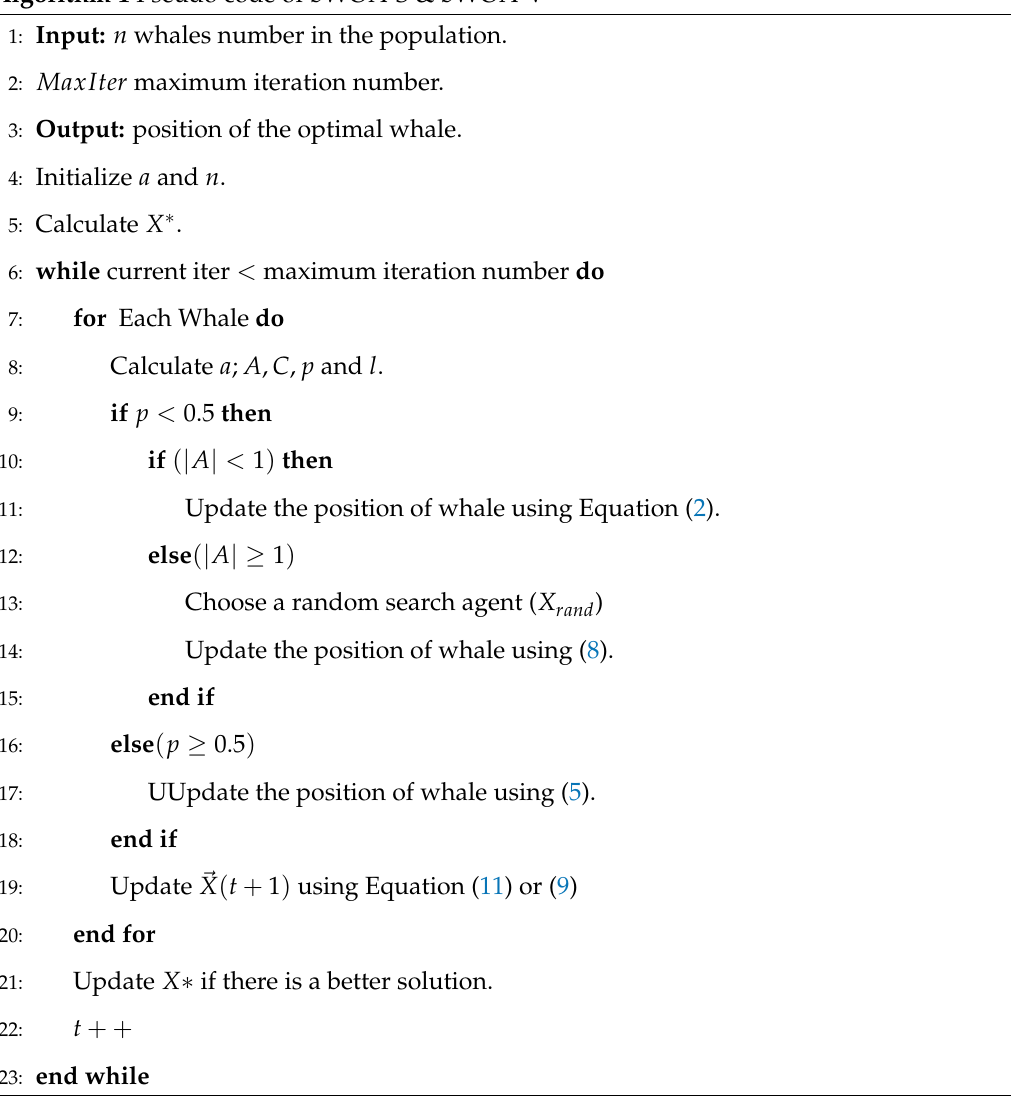
Algorithm 1 Pseudo code of bWOA-S &